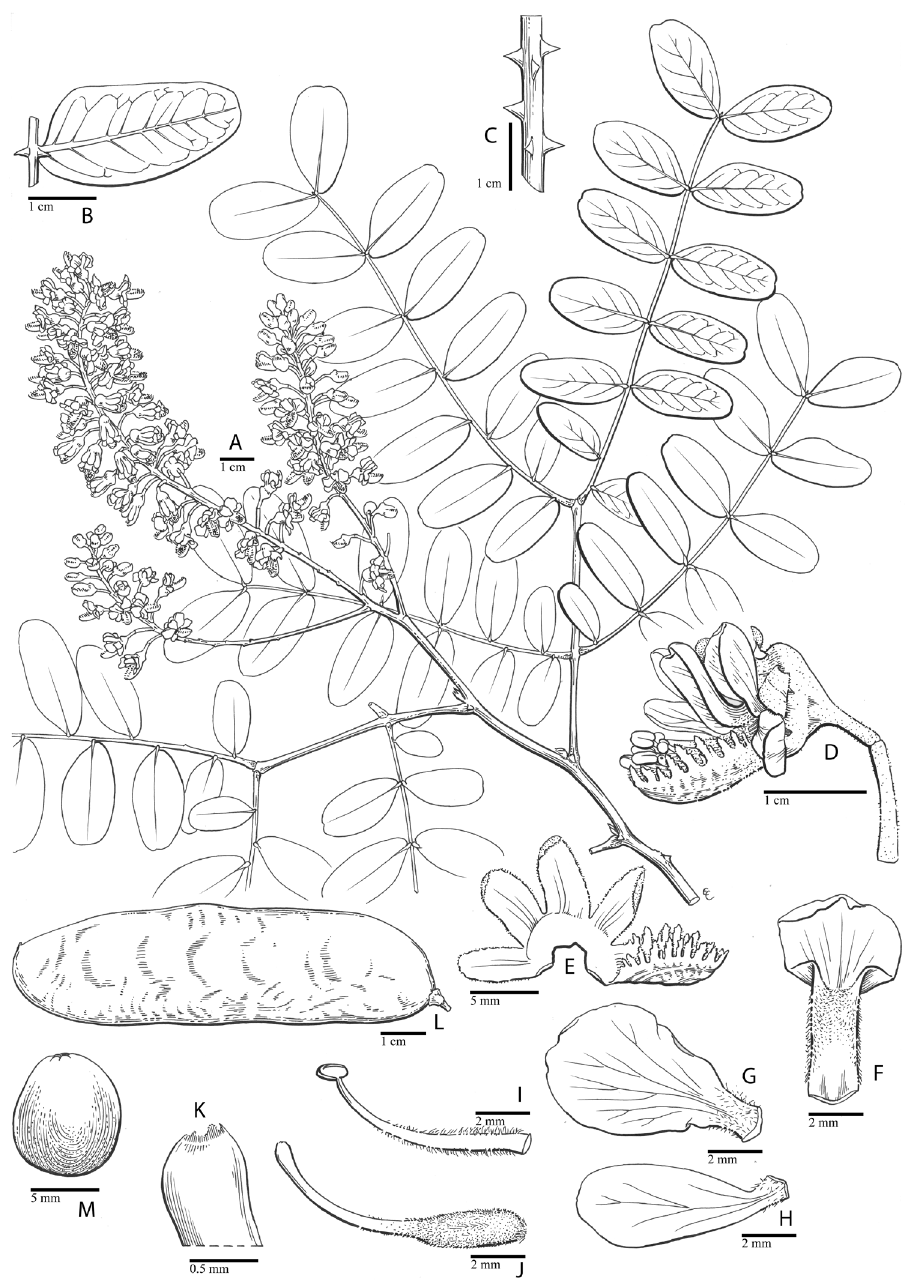
Figure 13. Tara spinosa (Molina) Britton & Rose. A habit B leaflet undersurface, C section of young stem D flower E calyx opened out F median petal G upper lateral petal H lower lateral petal I stamen J gynoecium K stigma L fruit M seed. A–K from Lewis 1416 L, M from Filskov et al. 37341. Drawn by Eleanor